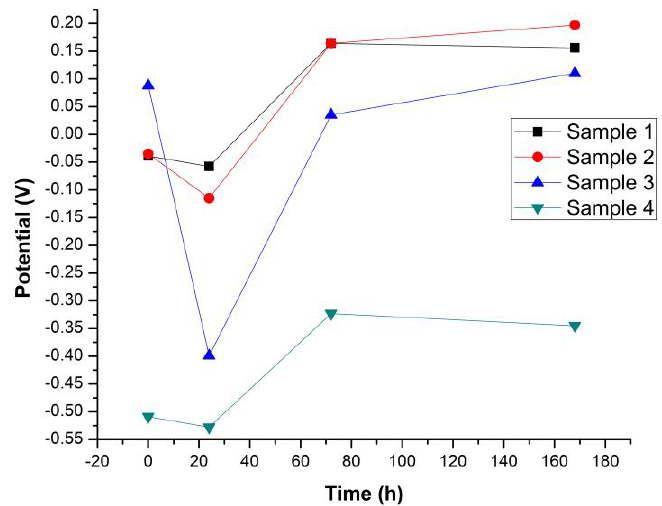
Figure 6. OCP diagrams for Samples 1–4, followed for 168 h.